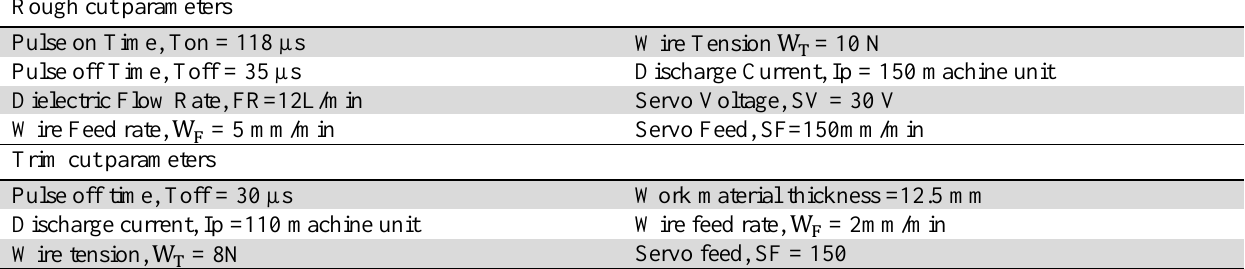
= 10 N W T = 2mm/min W F